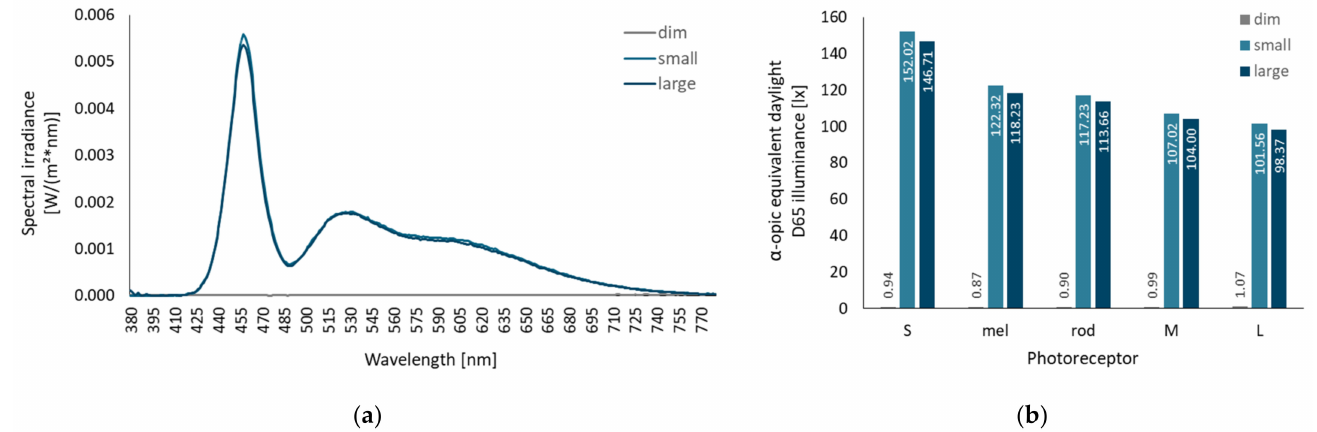
Figure 3. ( a ) Spectral irradiances vertical at eye position (see Figure 1a) used in the three experimen- tal conditions; ( b ) equivalent daylight (D65) illuminances in the experimental conditions for the five photoreceptor S-cones, melanopsin, rods, M-cones, and L-cones according to the CIE S 026/E:2018 standard